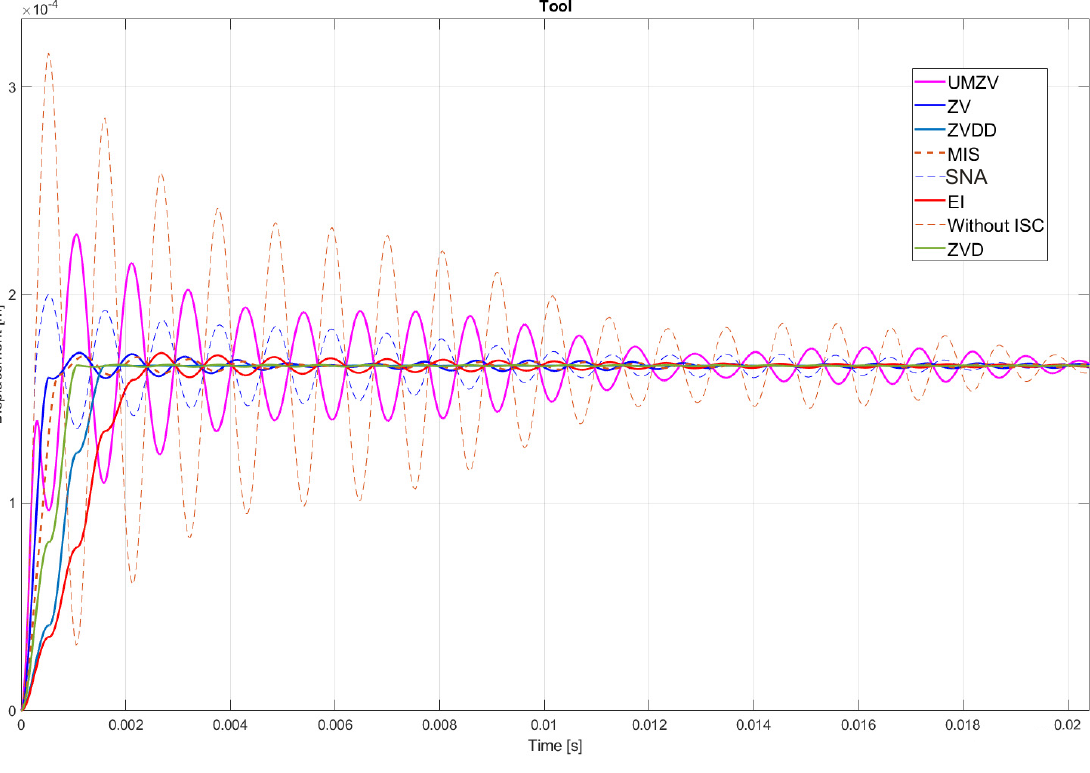
Figure 14. Tool displacement during medium precision machining: without ISC control, using UMZV, ZV, ZVD, ZVDD, MIS, SNA and EI algorithm .